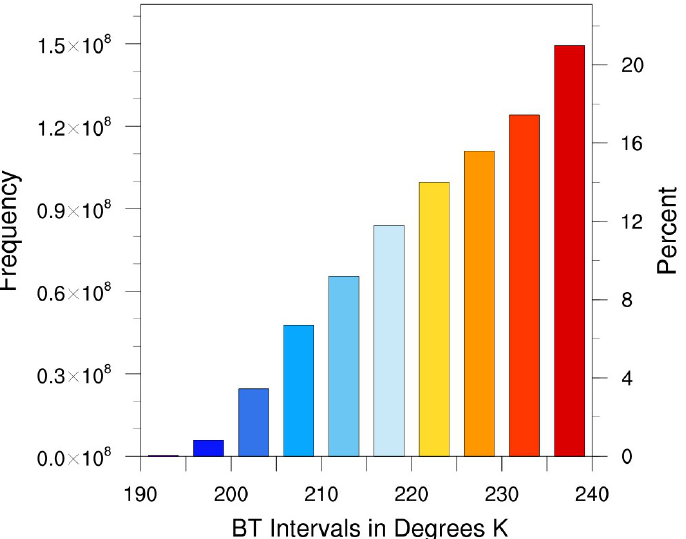
Figure 2. Histogram of all pixels that fall in the range 208K–240K during the period 1995–2017 in the A1